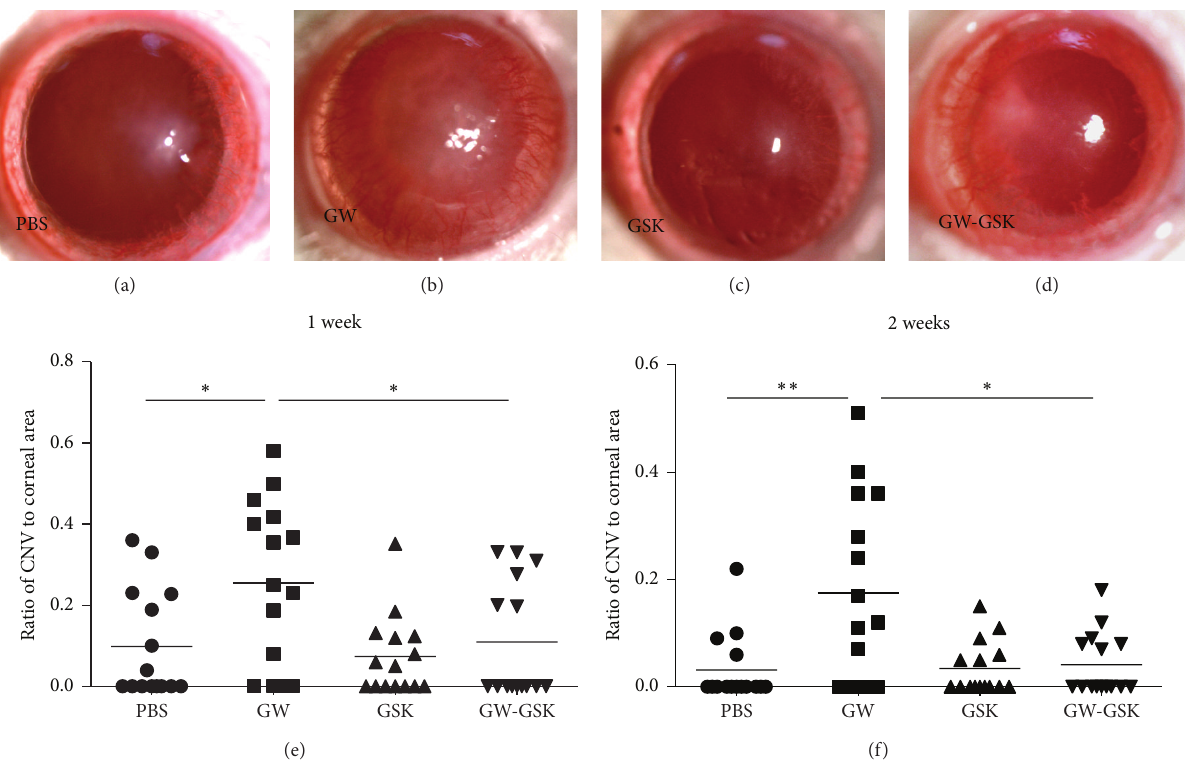
Figure 2: Subconjunctival injection of GW501516 promoted angiogenesis. Representative photographs of rats’ ocular surfaces are shown at one week after treatment with PBS (a), GW501516 (b), GSK3787 (c), and GW501516 combined with GSK3787 (d). The degrees of CNV in the GW501516 group were significantly higher than all other groups at one week (e) and two weeks (f) after surgery. The ranges of the 𝑦 -axis differ in each graph. The line represents the mean ( 𝑛 = 15 ), and differences were analyzed with a nonparametric test. ∗ 𝑃 < 0.05 versus GW501516 group.